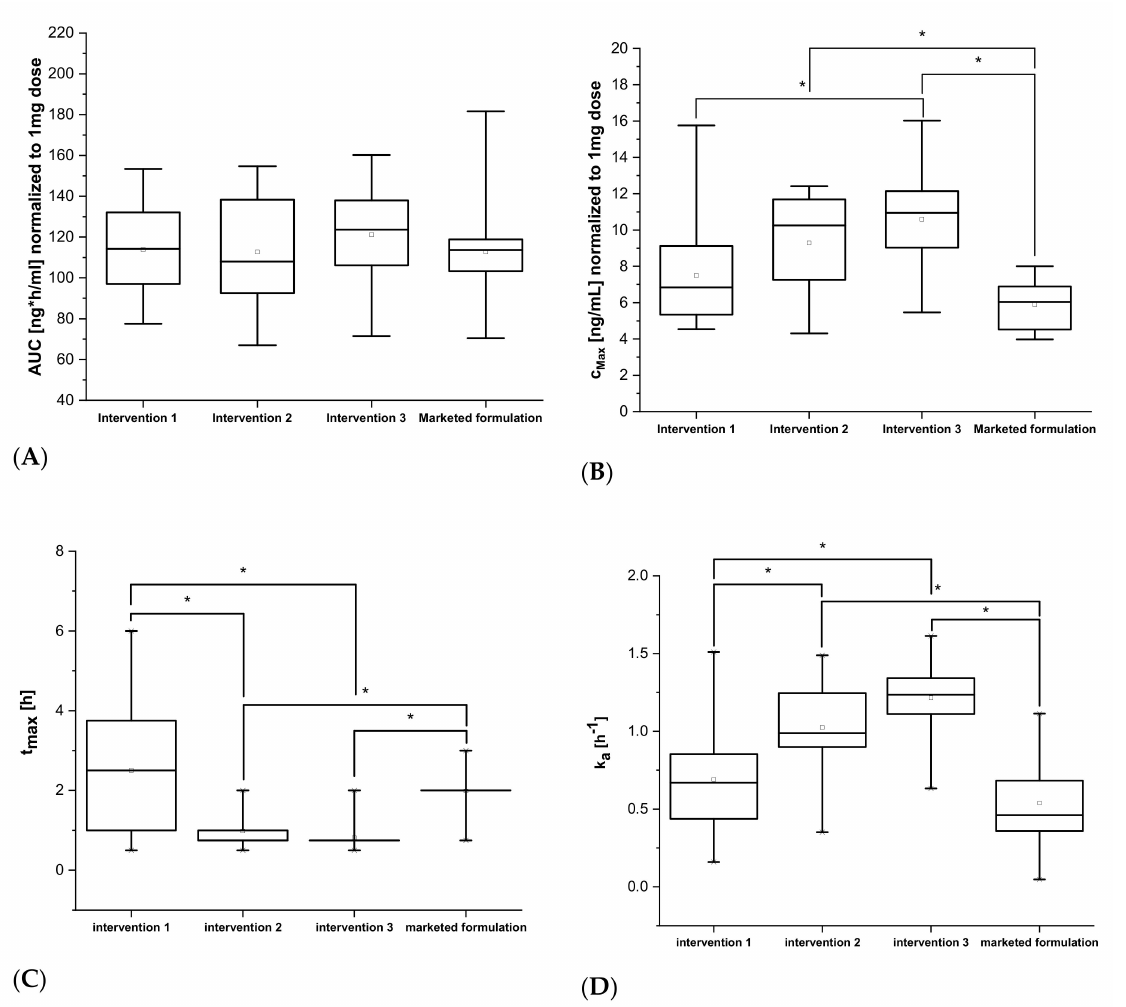
Figure 3. Box plots of normalized pharmacokinetic parameters retrieved from the non-compartmental analysis. The area under the curve AUC 0–t ( A ), maximum concentration C max ( B ) and the time of maximum concentration t max ( C ) as well as from two-compartment analysis, i.e., absorption constant k a ( D ) for intervention 1 (ASD of efavirenz 50 mg), intervention 2 (dissolved ASD of efavirenz 50 mg), intervention 3 (solution of efavirenz 3 mg), and the marketed formulation 50 mg [18] are shown. AUC 0–t and C max are normalized to a dose of 1 mg efavirenz. Boxes show the interquartile range with the median, whiskers show the 5th (low) and 95th (high) percentile, and the hollow squares the mean values. A statistically significant difference ( p < 0.05, Bonferroni test) is indicated by